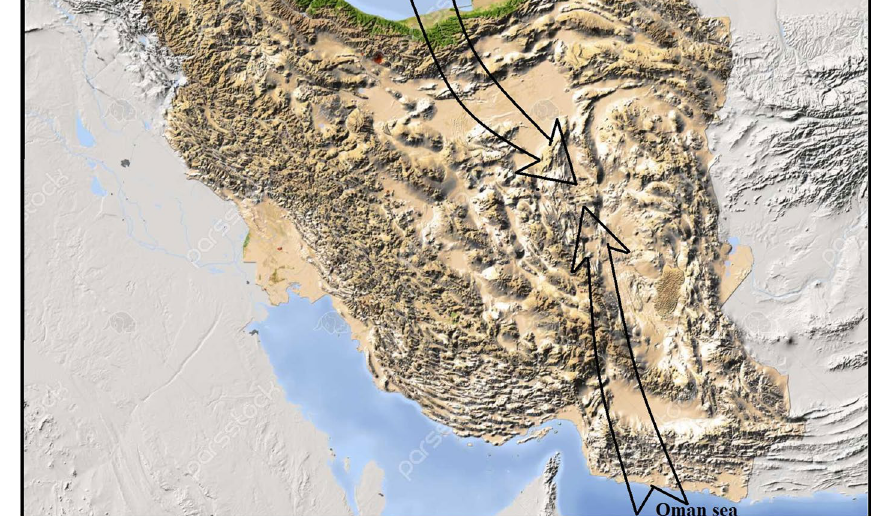
Iran and two proposed ways to transfer desalinated seawater to its central